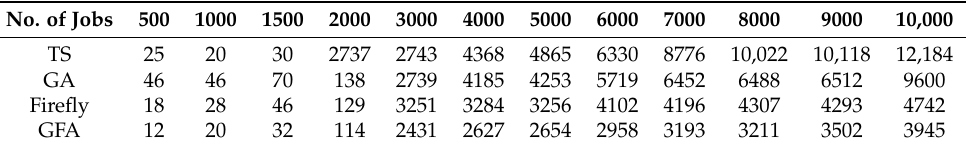
Table 4. Makespan times of The GFA Compared to Different Scheduling Methods for Different Workloads.